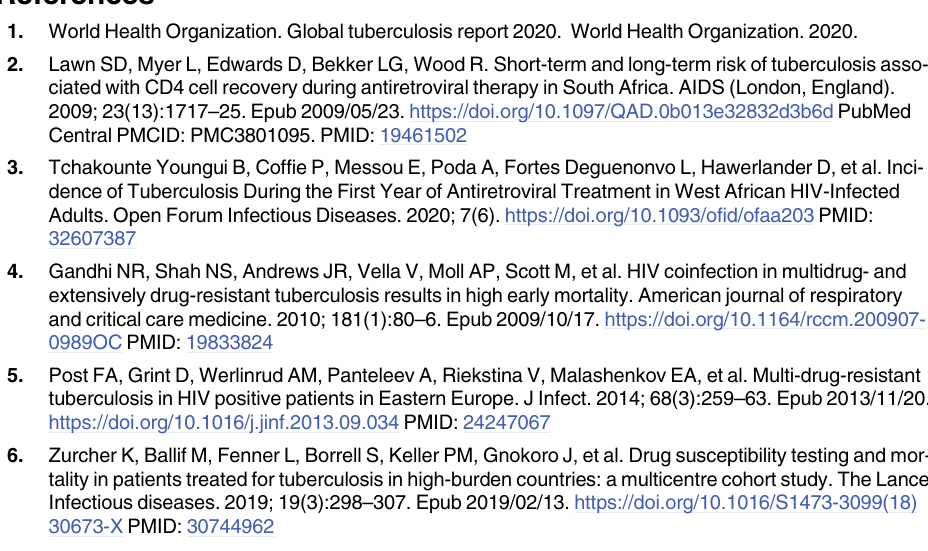
S6 Table. Strobe checklist. S7 Table. Participating programs and members of IeDEA.